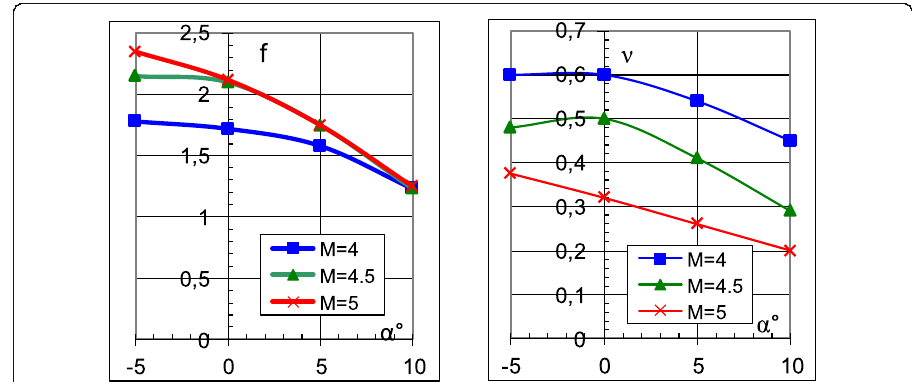
Fig. 9 The results of experimental study of the air intake throttling characteristics for the design based on the Busemann biplane concept: maximum values of the intake mass flow rate coefficient f and of the total pressure recovery factor ν vs. angle-of-attack of the model